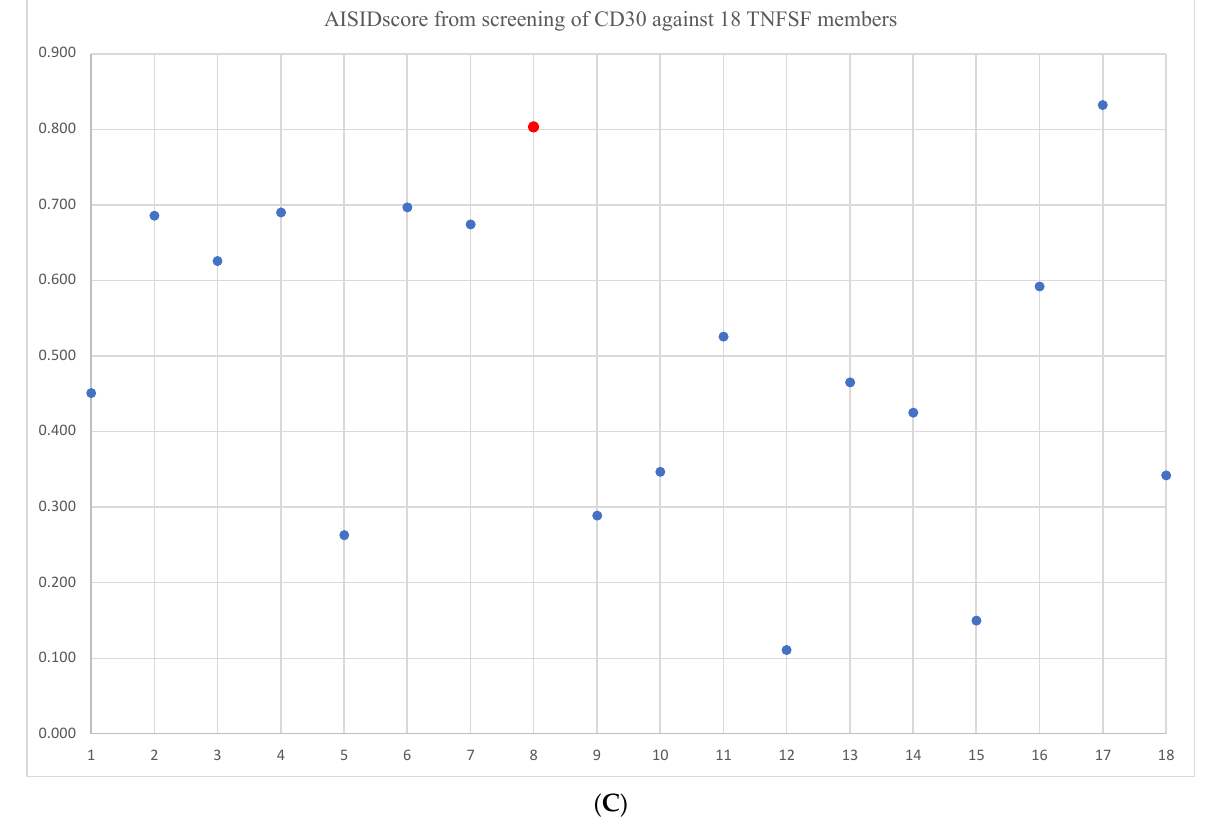
Figure 2. Plot of AISIDscores from screening the TNFRSF members, which do not have solved complex structures. ( A – C ), represent DcR1, DcR2, and CD30, respectively, with the 18 TNFSF members in same order as Figure 1. The red circle indicates the correct pairing.